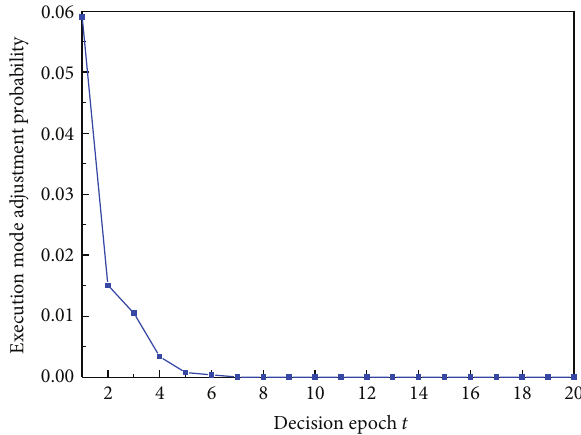
Figure 8: Execution mode adjustment probabilities at all decision